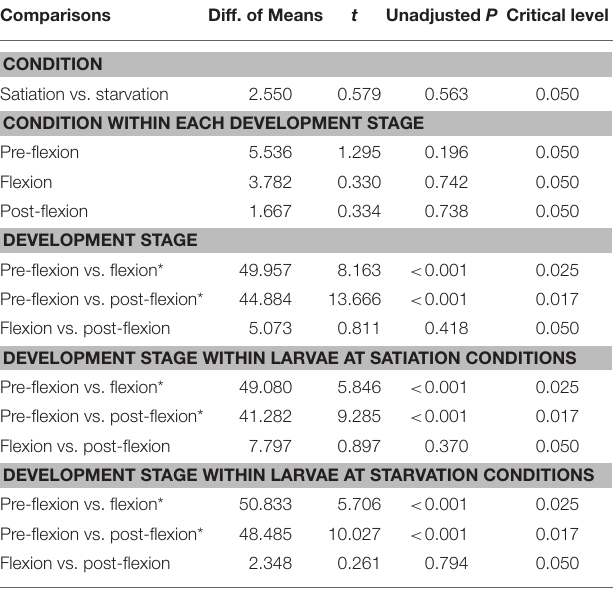
TABLE 4 | Multiple comparisons’ statistical output for the Minimum Consecutive Time (MinCT) index calculated for all larvae exhibiting an unresponsive behavior. Comparisons Diff. of Means Unadjusted P Critical level CONDITION Satiation vs. starvation